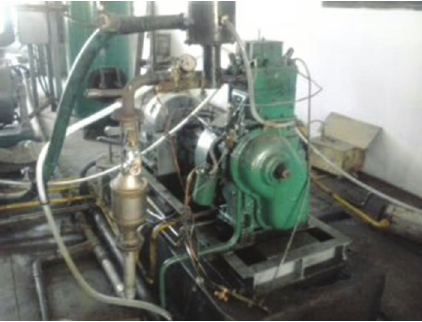
Figure 1: Experimental test rig.